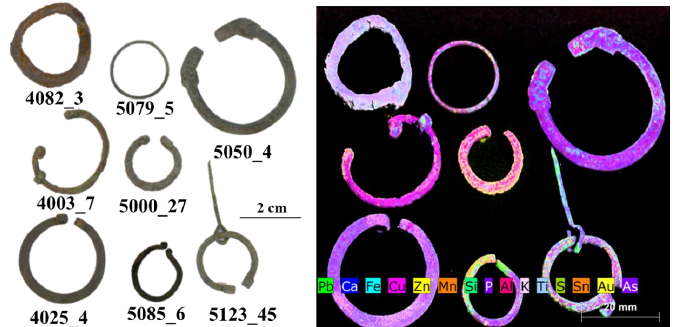
Figure 5. Photographs of the objects of the fibula/ring/earring group and the XRF mapping of the detected elements. J. Imaging 2020 , 6 , x FOR PEER REVIEW